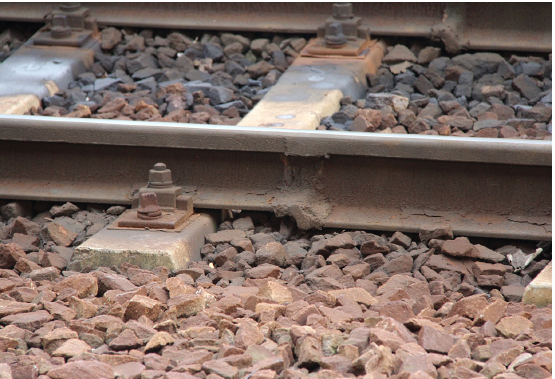
Figure 7. Thermite weld joining two rails with different profiles (50E5, UNI-50, on the right and 60E1, UNI-60, on the